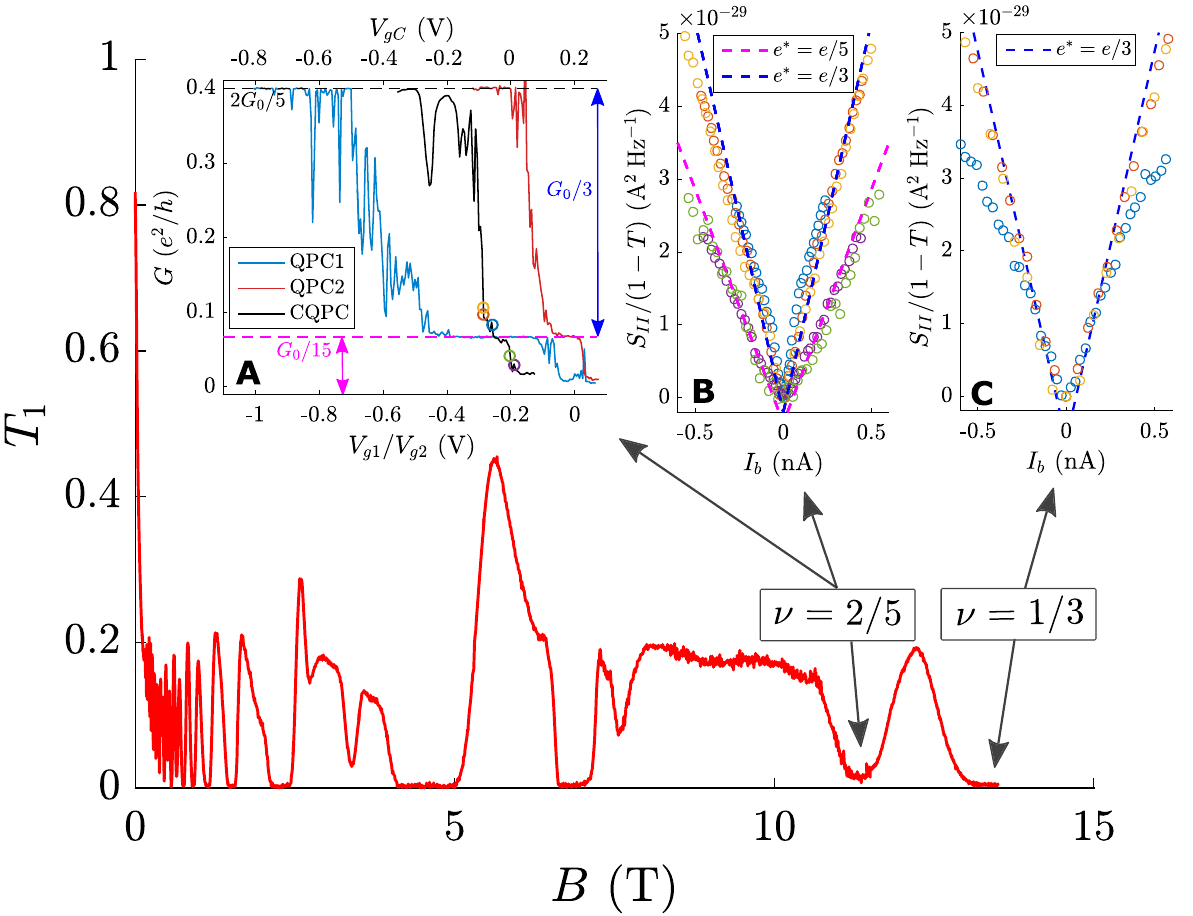
FIG. 2. Edge structure and fractional charges. Backscattering probability T 1 ¼ δ I 5 = δ I 7 as a function of the magnetic field B . Inset A: backscattering conductance G ð V ¼ 0 Þ of QPC1, QPC2, and CQPC as a function of the QPC gate voltages at filling factor ν ¼ 2 = 5 . The colored circles correspond to the value of the conductance for the noise measurements plotted in inset B. Inset B: measurement of the noise S II at the output of CQPC normalized by the factor ( 1 − T ) as a function of the backscattered current I b at filling factor ν ¼ 2 = 5 . Green and violet circles correspond to the partitioning of the inner channel whereas the blue, red, and yellow circles correspond to the partitioning of the outer channel. The magenta dashed line is S II = ð 1 − T Þ ¼ 2 e (cid:2) I b , with e (cid:2) ¼ e= 5 , whereas the blue dashed line corresponds to the fractional charge e (cid:2) ¼ e= 3 . Inset C: measurement of the noise S II at the output of CQPC normalized by the factor ( 1 − T ) as a function of the backscattered current I b at filling factor ν ¼ 1 = 3 . The blue circles correspond to T ð V ¼ 0 Þ ¼ 0 . 14 , the red circles to T ð V ¼ 0 Þ ¼ 0 . 29 , and the yellow circles to T ð V ¼ 0 Þ ¼ 0 . 36 . The blue dashed line is S II = ð 1 − T Þ ¼ 2 e (cid:2) I b , with e (cid:2) ¼ e= 3